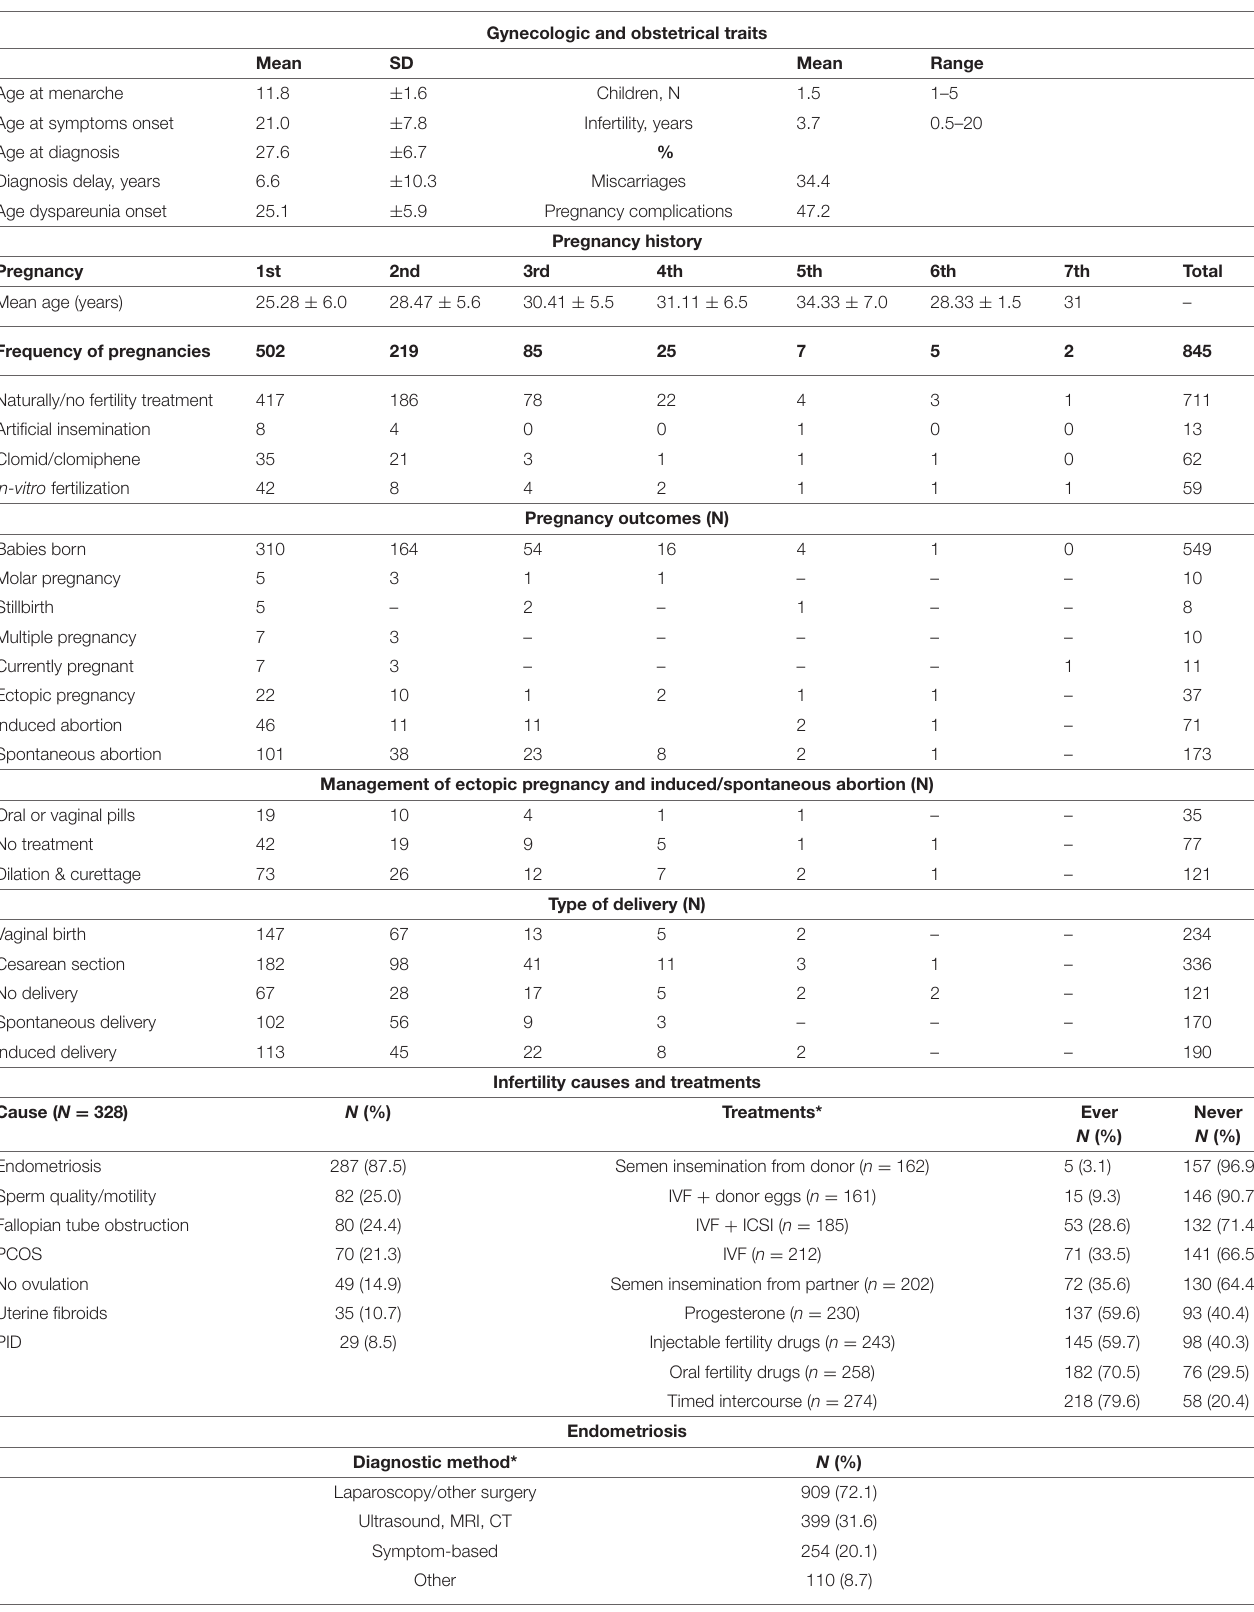
TABLE 2 | Gynecologic and obstetrical traits of endometriosis patients from Ibero-America.